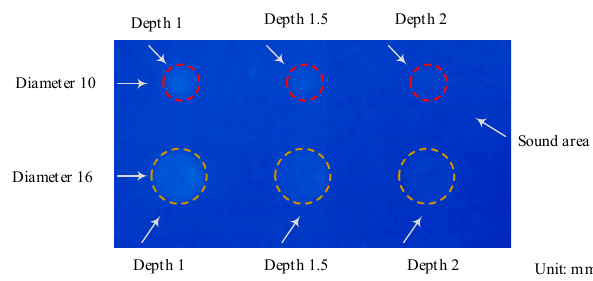
Figure 9. Schematic diagram of different defect areas.